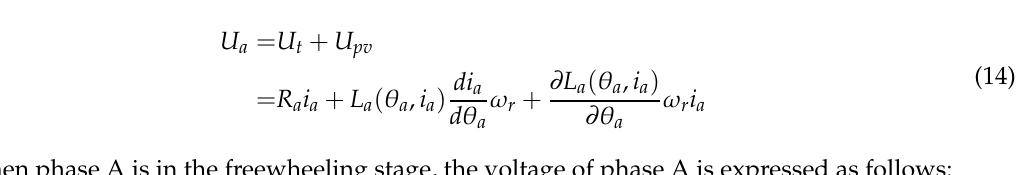
Figure 6. The working stage of the SRM system powered by the PV panels and battery pack together. ( a ) Excitation stage. ( b ) Chopper freewheeling stage. ( c ) Freewheeling stage. When phase A is in the excitation stage, the voltage of phase A is expressed as Mode 3: When the aircraft is powered by the PV panels, switch S 9 is turned off and switch S 10 is turned on. The working stages are similar to the SRM system powered by the battery pack, and the difference is that PV panels act as a power source instead of the battery pack, and the magnitude of the phase voltage is different, as shown in Figure 3d.